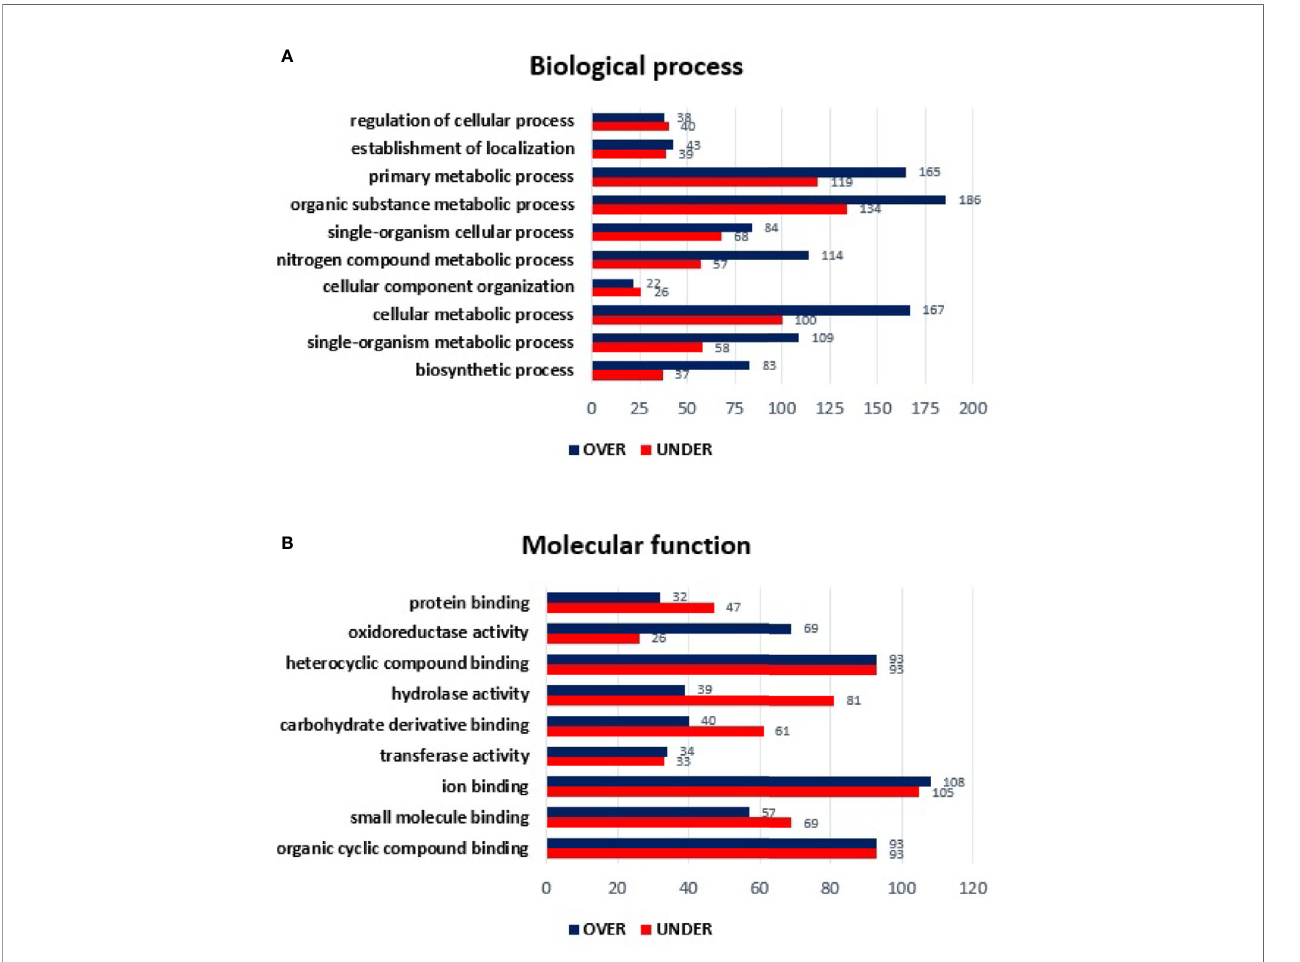
FIGURE 2 | Gene ontology of differentially represented proteins from salivary glands of R. sanguineus tropical lineage vs. R. sanguineus temperate lineage in the non-infection condition. GO terms and its representation of biological process (A) , and molecular function (B) were obtained using level 3. Blue bars represent the number of over-represented proteins in the tropical lineage compared to the temperate lineage and red bars represented the number of under-represented proteins in the tropical lineage compared to the temperate lineage (can be interpreted as the number of proteins more represented in the temperate lineage compared to the tropical lineage), with statistical signi fi cance ( p <